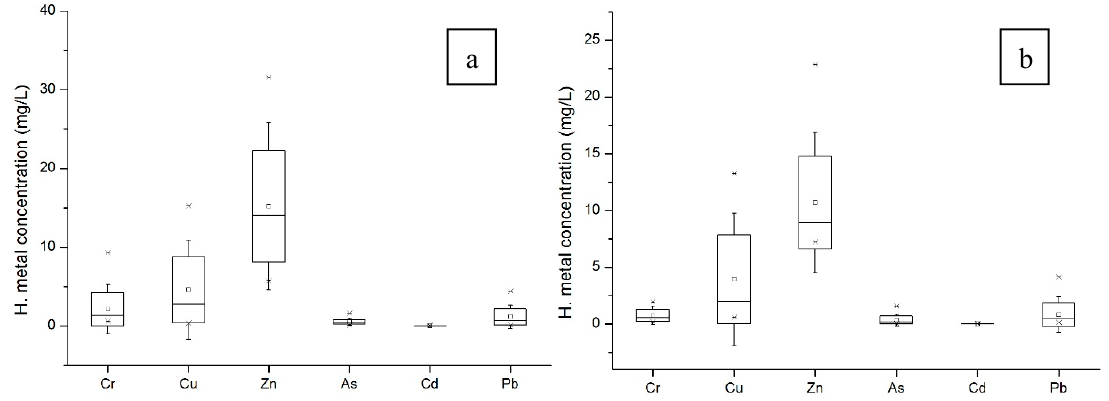
Figure 2. Box and whisker plots with standard deviation in irrigation water in ( a ) dry season and ( b ) wet season.